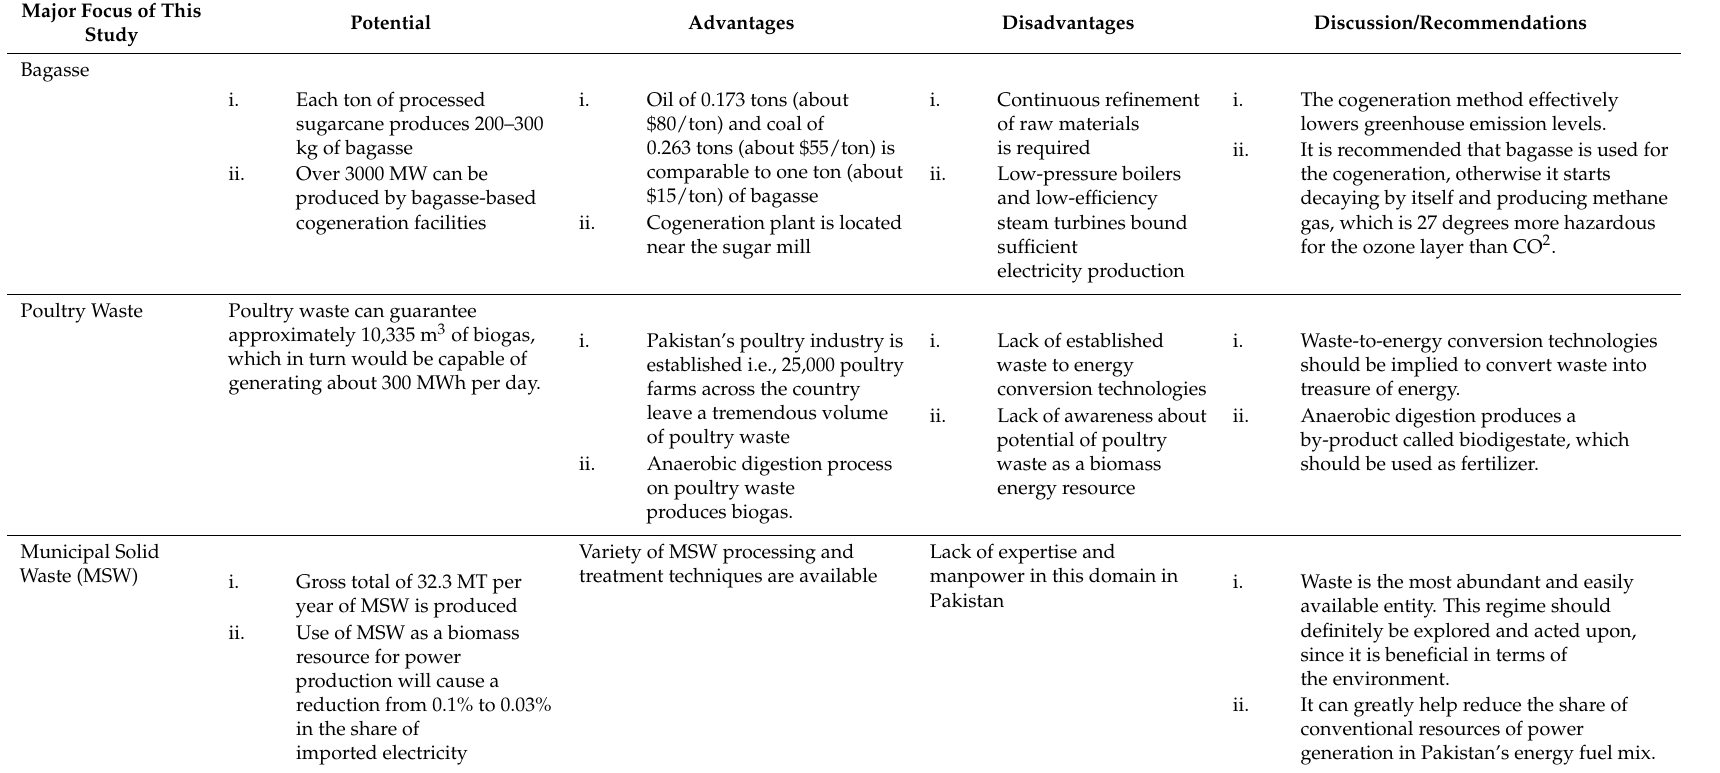
Table 27. Analysis of major biomass